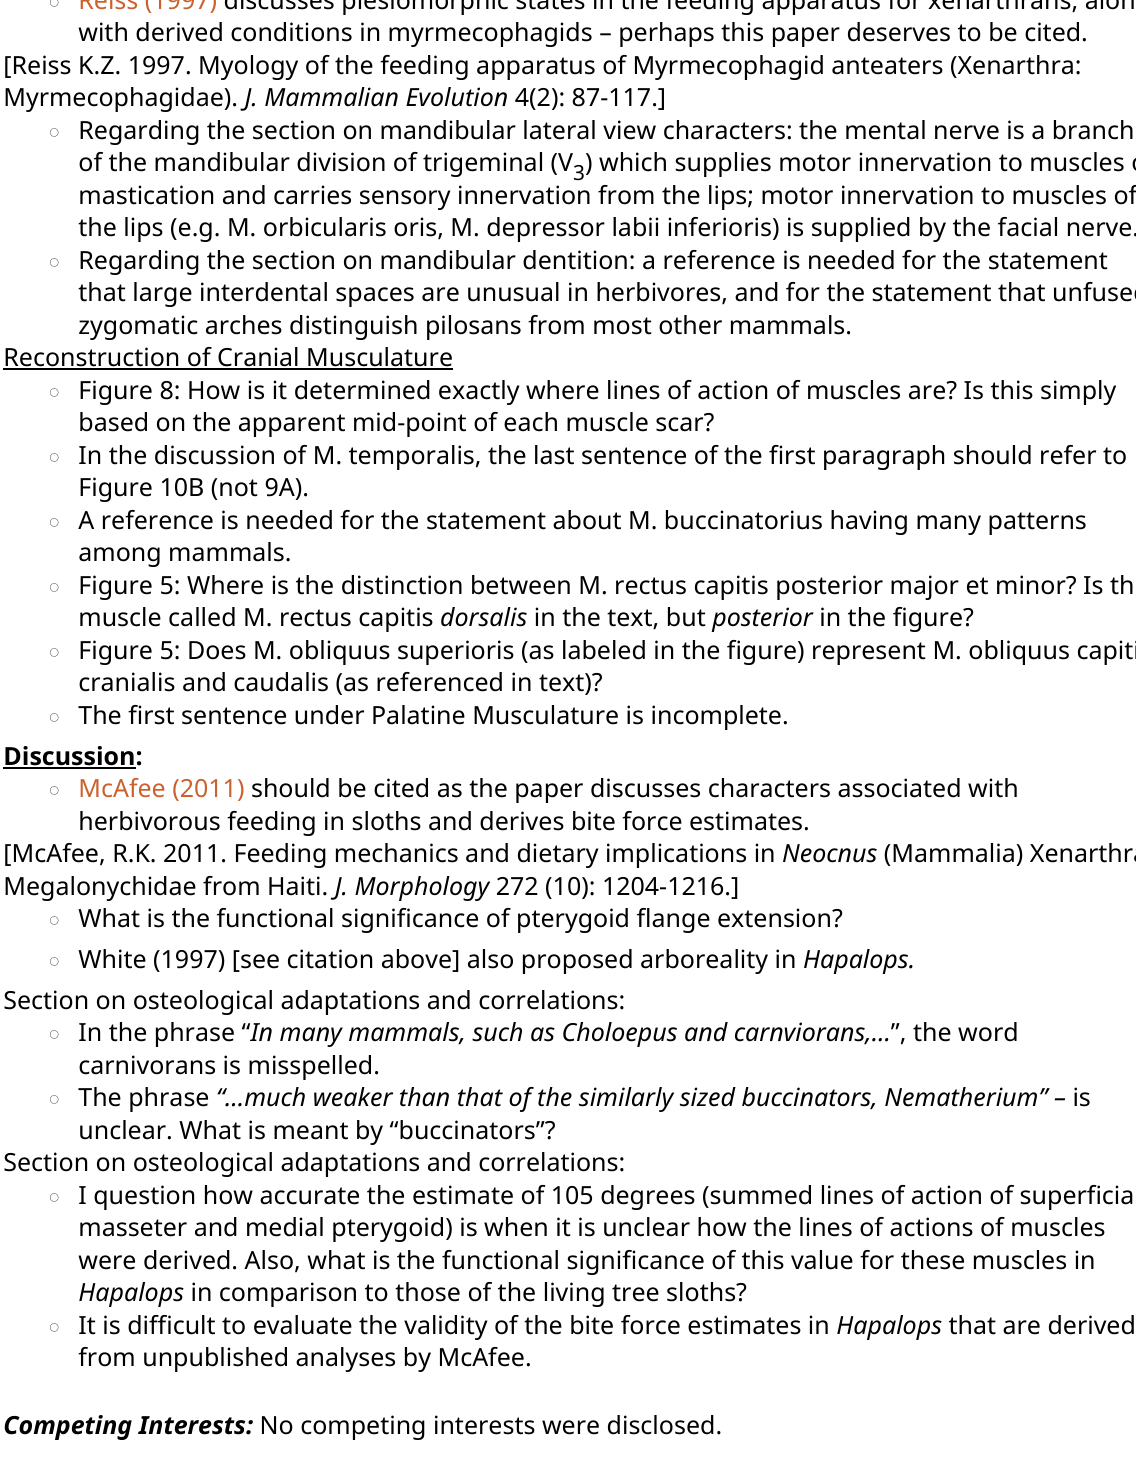
Figure 8: How is it determined exactly where lines of action of muscles are? Is this simply based on the apparent mid-point of each muscle scar?